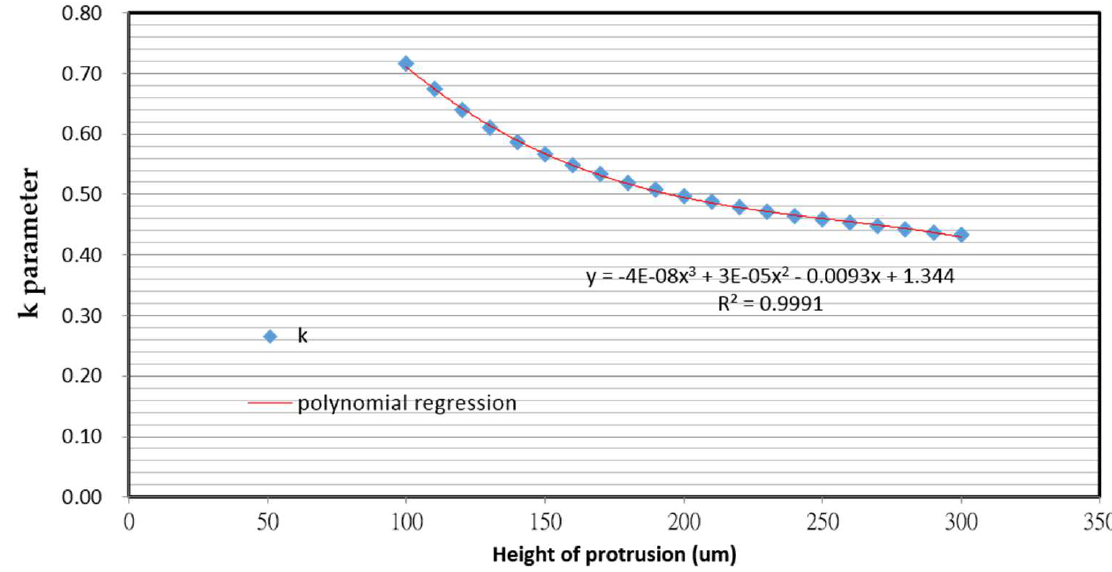
Figure 6. The variation of k versus protrusion height.